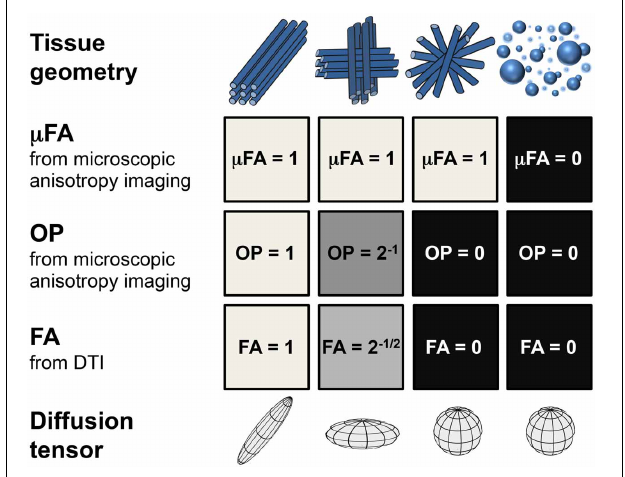
FIGURE 1 | Idealized tissue geometries with corresponding structure parameters. Consecutive rows show values of the microscopic fractional anisotropy, μ FA; orientational order parameter, OP; fractional anisotropy, FA; and diffusion tensors. Decreasing values of OP from left to right in columns 1–3 leads to a reduction of FA while μ FA remains constant. For isotropic structures (column 4), both FA and μ FA